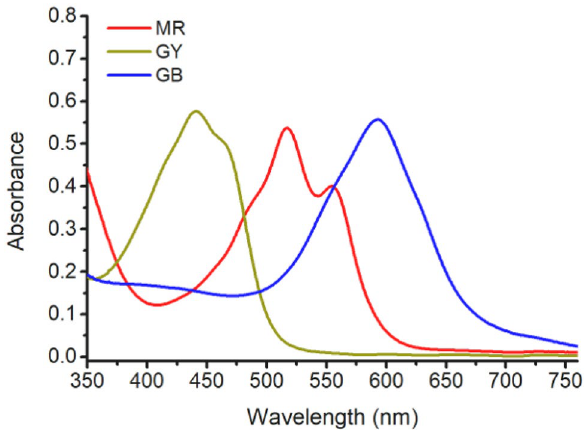
Figure 4. Light absorbance of MR, GB, and GY dye solutions.